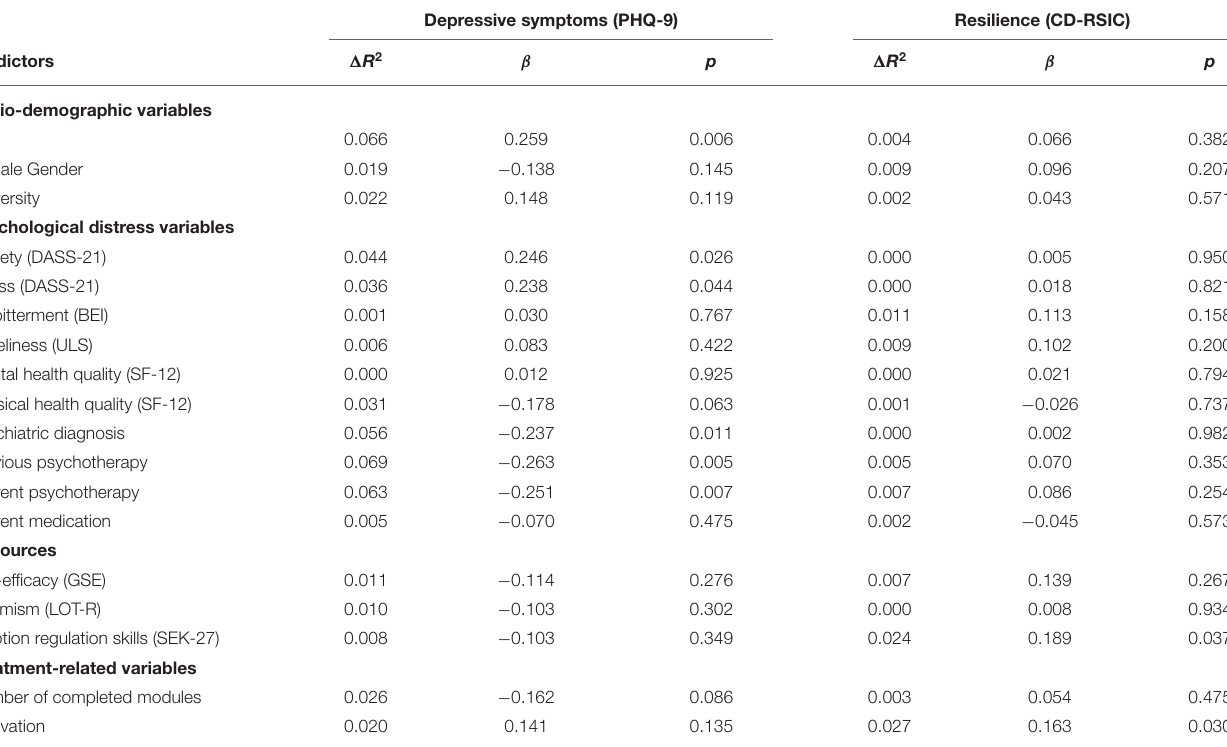
TABLE 2 | Single-predictor linear regression analysis with post-treatment depressive symptoms respectively post-treatment resilience as dependent variable controlling for pre-treatment depressive symptoms, respectively pre-treatment resilience. Depressive symptoms (PHQ-9) Resilience